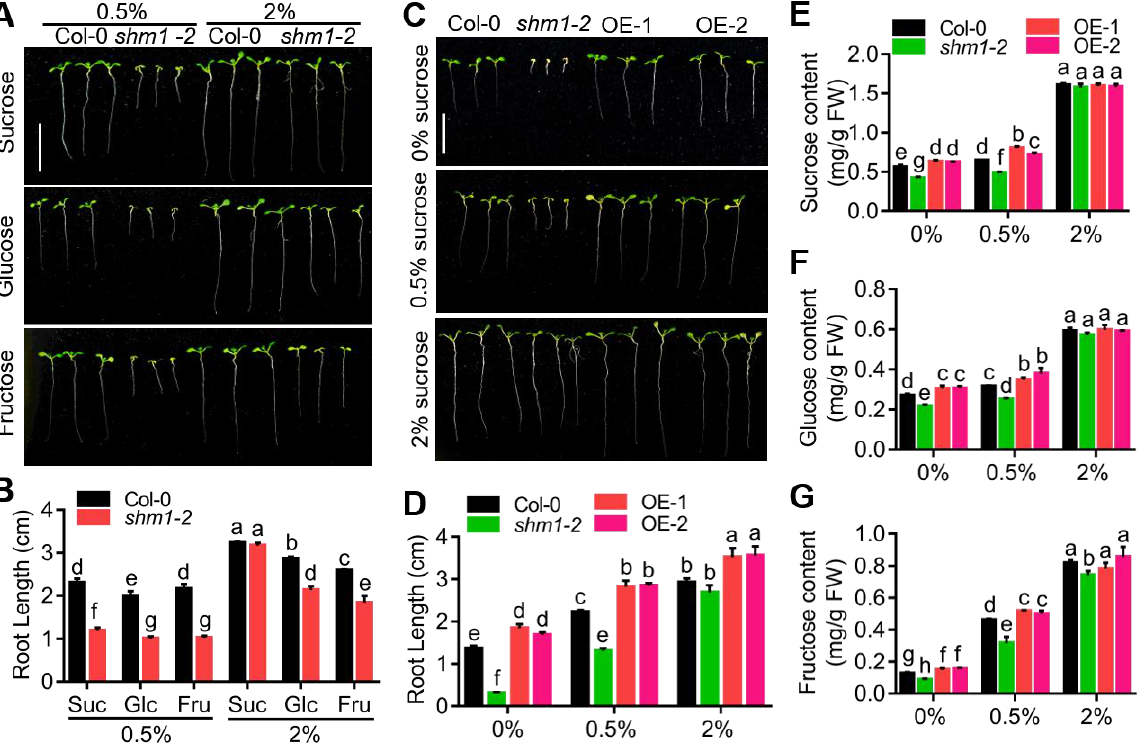
Figure 2. Exogenous sucrose supply rescued the root-growth-arrest phenotype of shm1-2 mutant. ( A , B ) The root-growth phenotype ( A ) and root length ( B ) of shm1-2 and Col-0 on 1/2 MS medium containing 0.5% or 2% sugars for 8 days. ( C , D ) The root-growth phenotype ( C ) and root length ( D ) of Col-0, shm1-2 and SHMT1 OE grown on 1/2 MS medium containing 0%, 0.5%, or 2% sucrose for 8 days. Bars = 1.5 cm. Data presented were means ± SEM, n = 3 experiments; each line had 10 roots per experiment. ( E – G ) The content of sucrose ( E ), glucose ( F ), and fructose ( G ) in Col-0, shm1-2 and SHMT1 OE seedlings in ( C ). Data presented were means ± SEM, n = 3. Different letters above error bars indicated significant difference at p < 0.05, using two-way ANOVA with Tukey’s test.